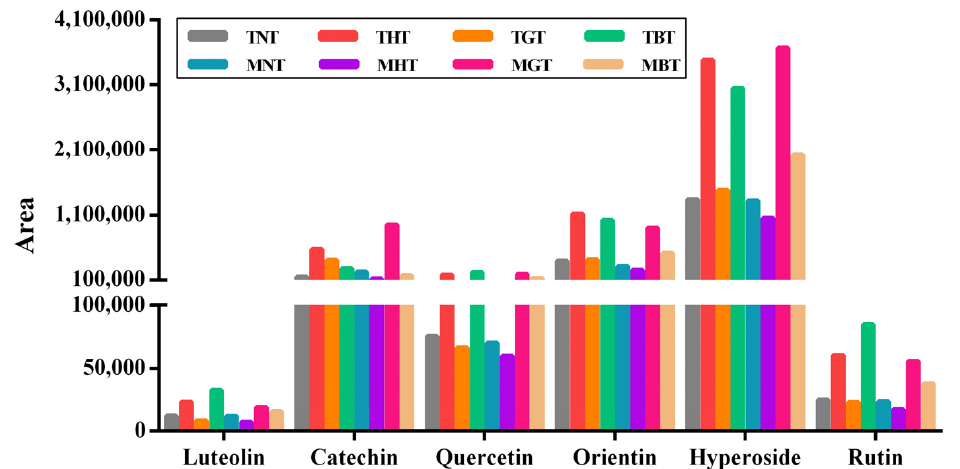
Figure 6. Comparison of the contents of luteolin, catechin, quercetin, orientin, hyperoside and rutin in lotus-leaf teas.